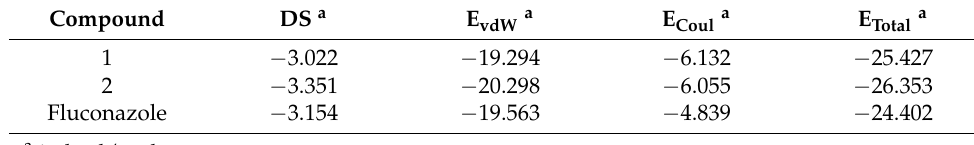
Figure 11. The docking structures and interaction maps of studied compounds. Table 8. Molecular docking results.